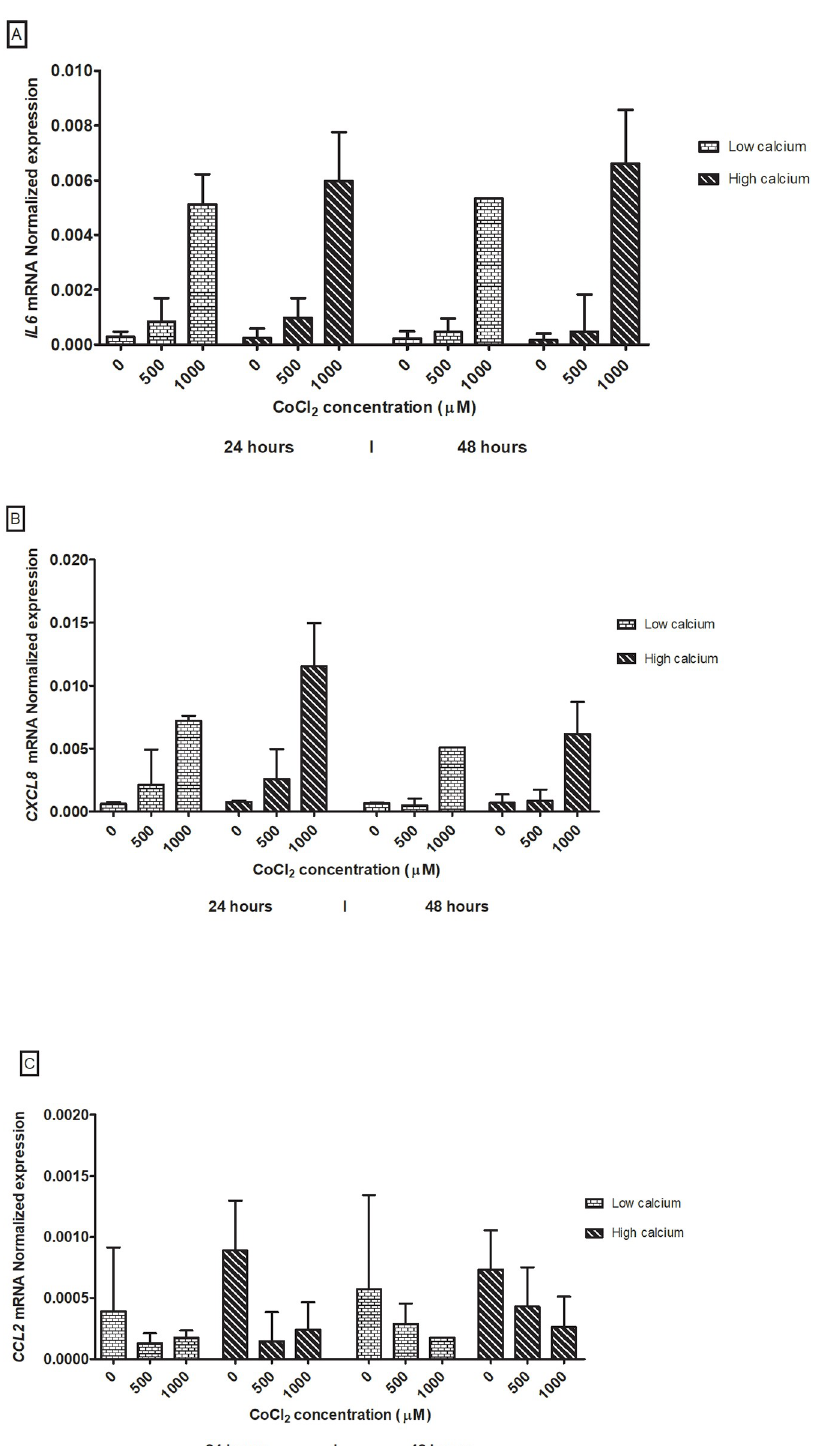
Fig 6. Gene expression of IL6 (A), CXCL8 (B) and CCL2 (C) in HaCaT cells exposed to cobalt chloride. The HaCaT cells were exposed for 24 and 48 hours to cobalt chloride concentrations 0 μ M, 500 μ M and 1000 μ M CoCl 2 . High (1.8 mM) and low (0.15 mM) calcium growth conditions is showed. Results represent median value of the relative mRNA levels and range (min-max). The IL6 , CXCL8 and CCL2 mRNA production was dose- and time-dependent and CXCL8 mRNA production was affected by the calcium incubation